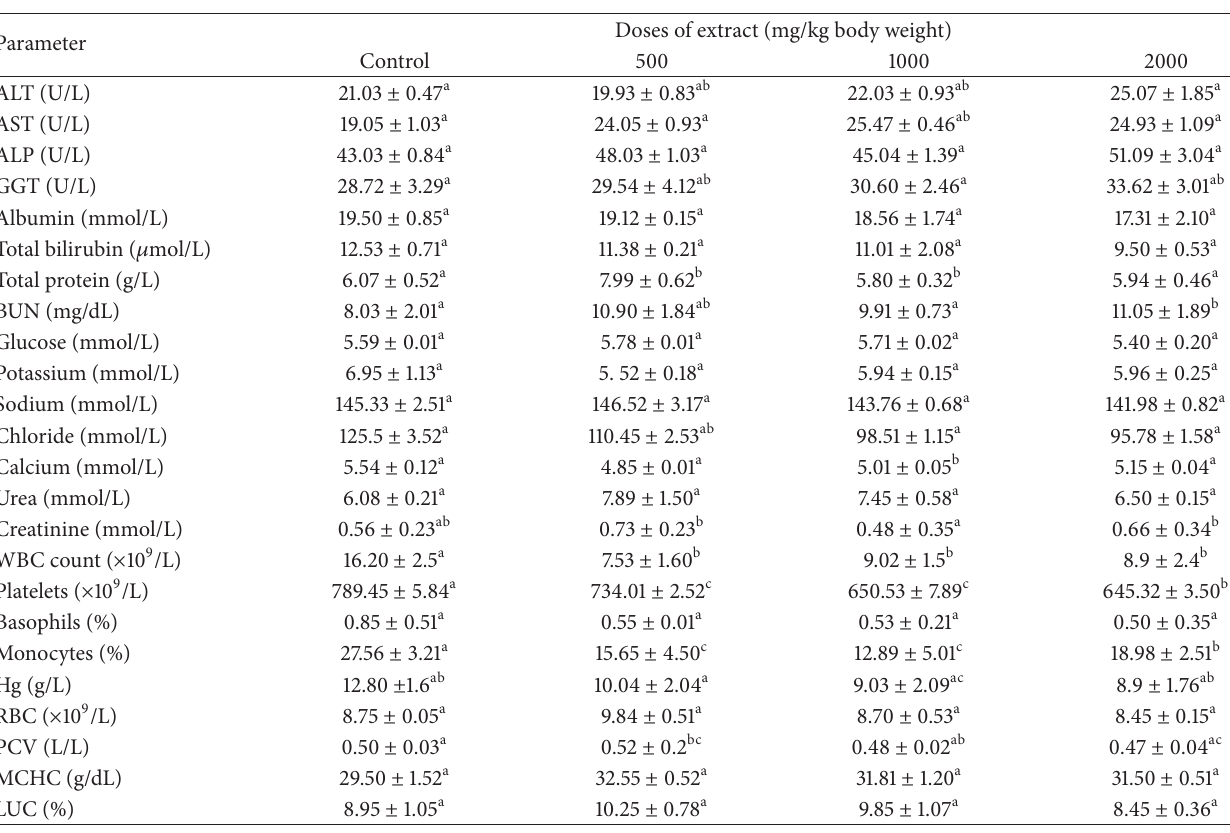
Table 3: Effects of methanolic leaf extract of J. curcas on plasma biochemical parameters of laboratory rats ( 𝑛 = 6 , mean ±